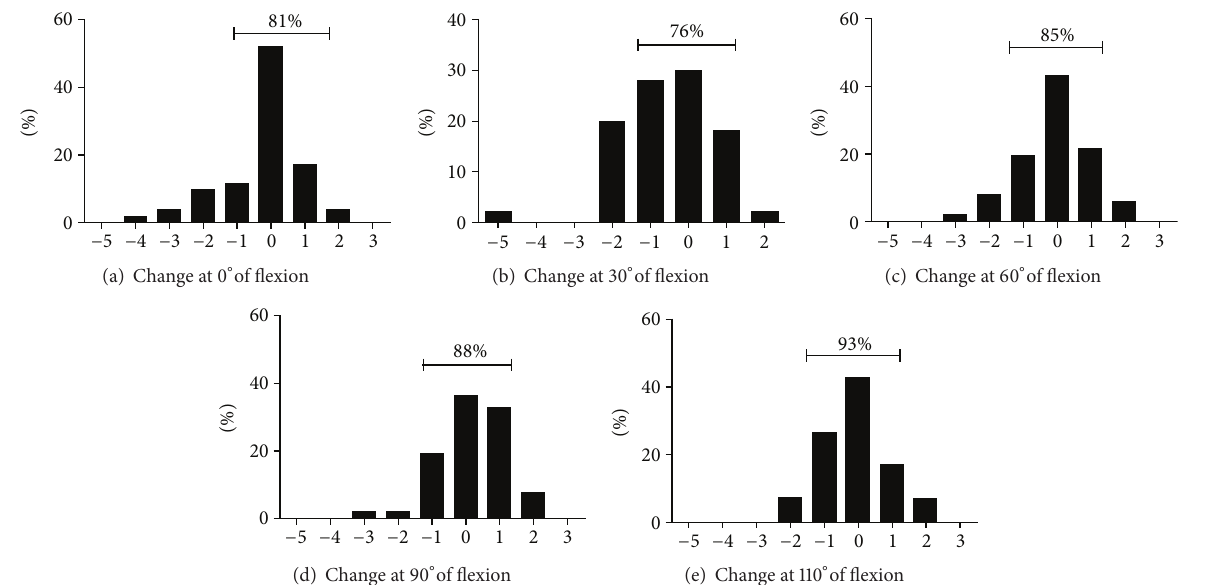
Figure 3: At 0 ∘ (a), 60 ∘ (c), 90 ∘ (d), and 110 ∘ (e), ligament balance between 1mm and − 1mm was achieved in 81% to 93% of cases. At 30 ∘ (b), 76% of cases were balanced between 1mm and − 1mm due to a necessary increase in ligament